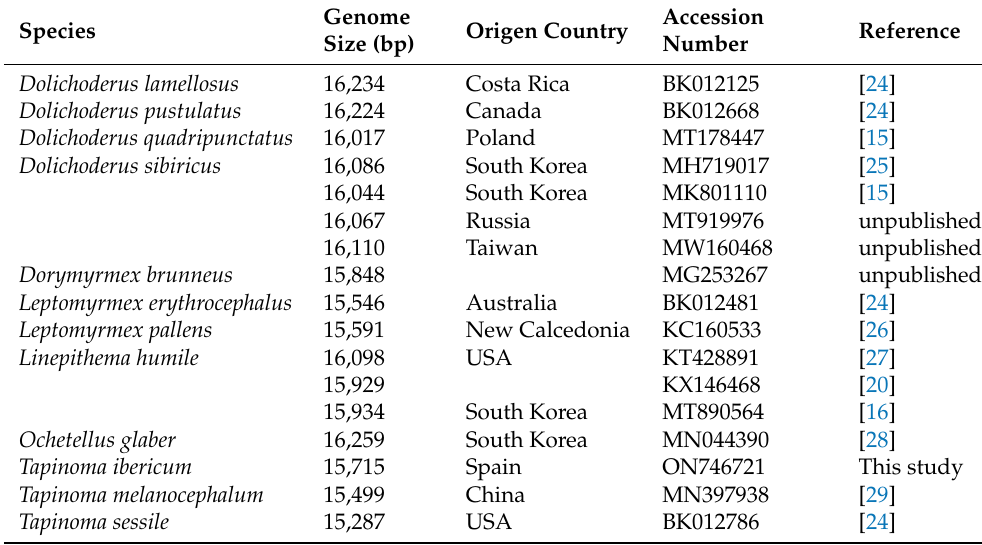
Table 1. The mitochondrial genomes currently sequenced in the subfamily